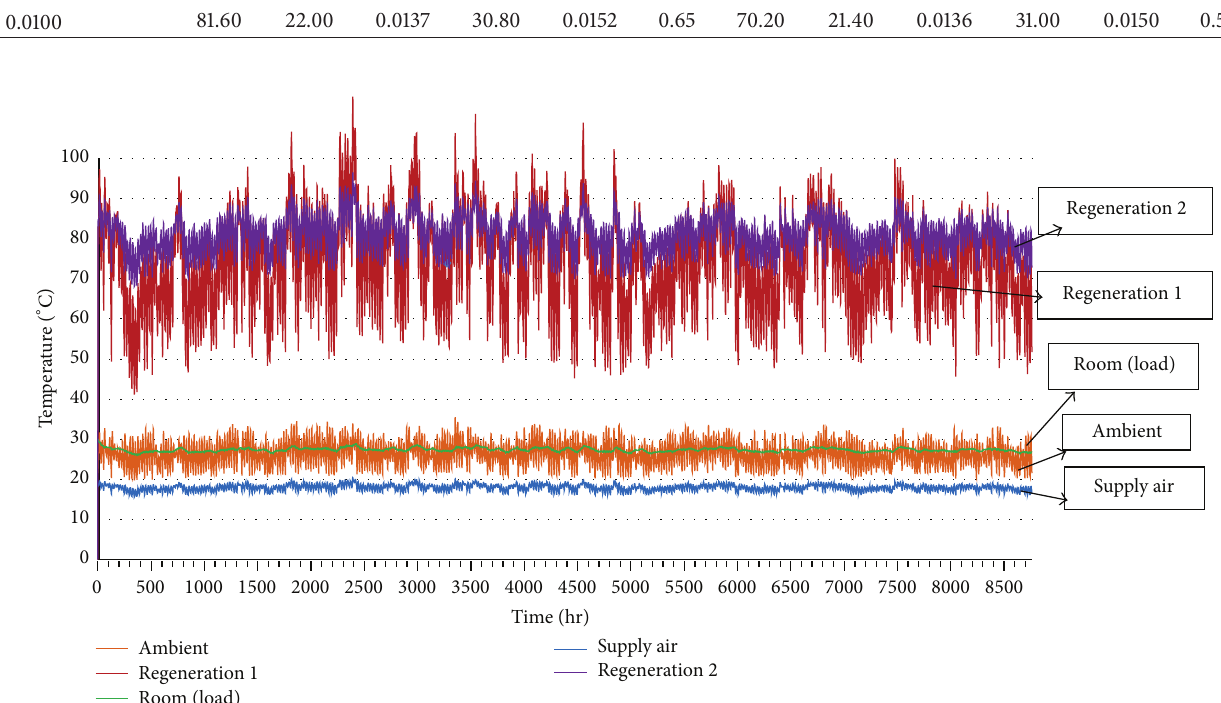
Figure 11: Temperatures ( ∘ C) of different components versus time (hr) in two-stage ventilation desiccant cooling